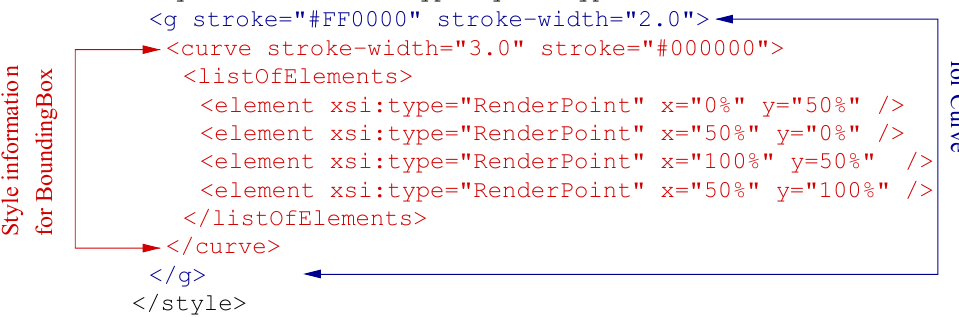
Figure 29: style with render information for objects with curve or bounding